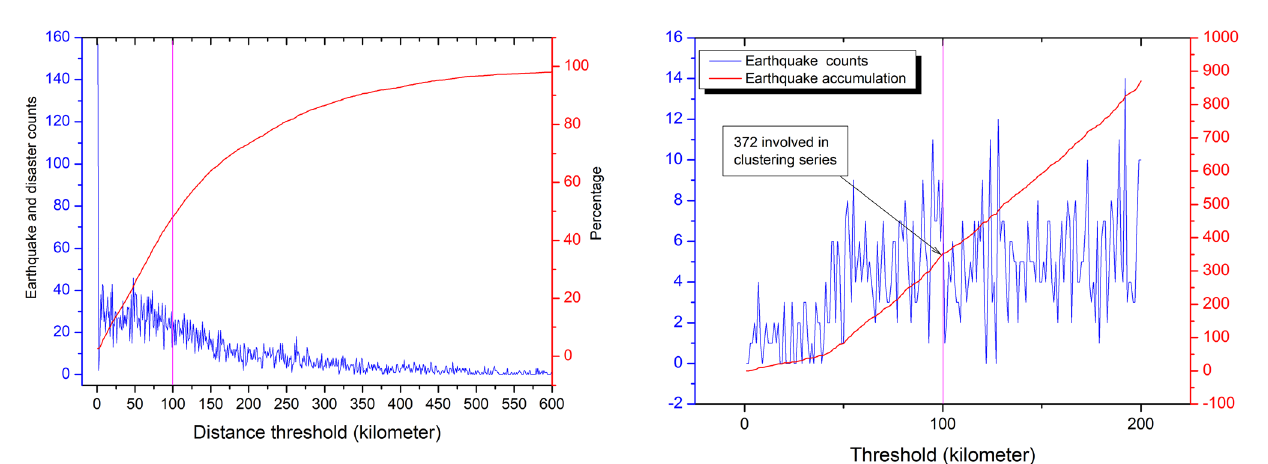
Fig. 9 Earthquake counts. Left y axis: earthquake counts in cluster series; right y axis: earthquake accumulation; x axis: space threshold among disaster mines (100-km threshold and 2-day